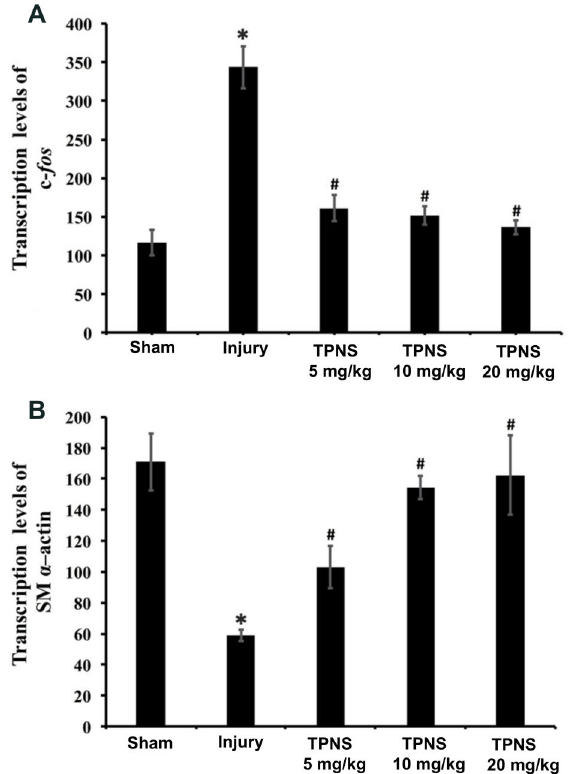
Figure 4. Effects of total Panax notoginseng saponin (TPNS) on c- fos and smooth muscle (SM) a -actin mRNA expression in injured arteries. The total expression levels of c- fos and SM a -actin mRNA in the artery walls in the sham group, injury group, low, medium, and high dose TPNS-treatment groups (5, 10, and 20 mg (cid:3) kg – 1 (cid:3) day – 1 ) are shown in A and B , respectively. Data are reported as means ± SE of 10 rats per group. *P o 0.05 compared to Sham; # P o 0.05 compared to injury (ANOVA and Tukey ’ s HSD post hoc